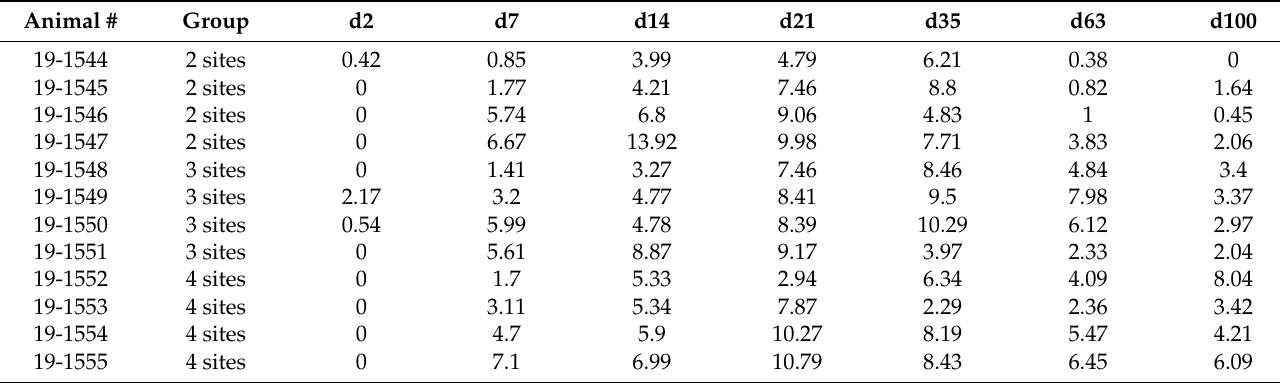
Table A2. Raw data used for Figure